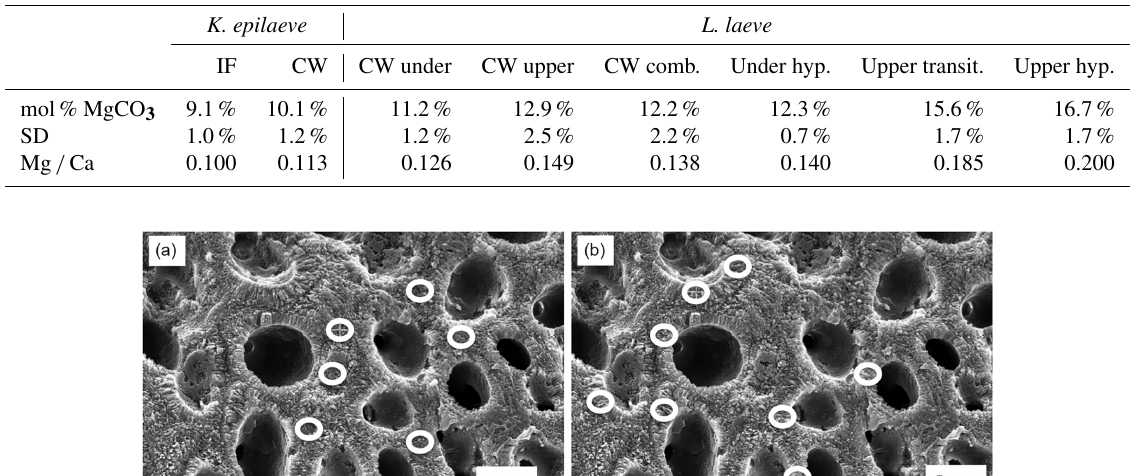
Table 1. SEM-EDS results. Conversion of mol% to Mg / Ca is included.